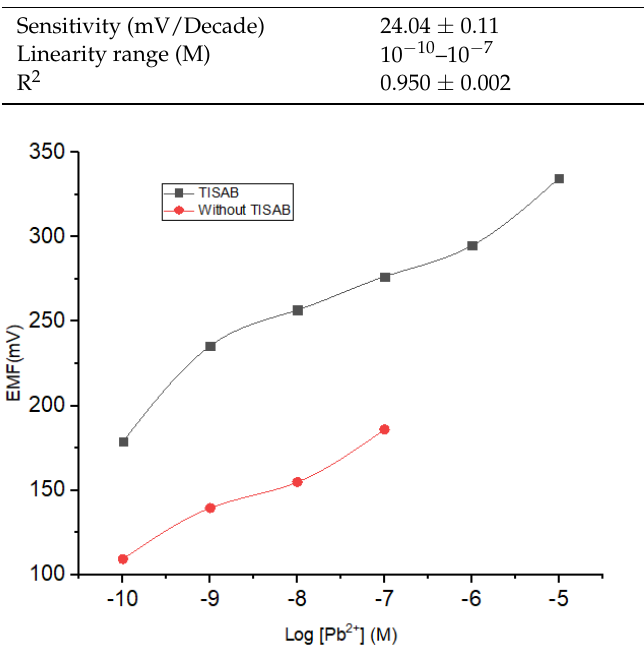
Figure 6. Effect of TISAB on the sensitivity and linearity range of ISE Pb 2+. Table 3. TISAB solution comparison profile and without TISAB.